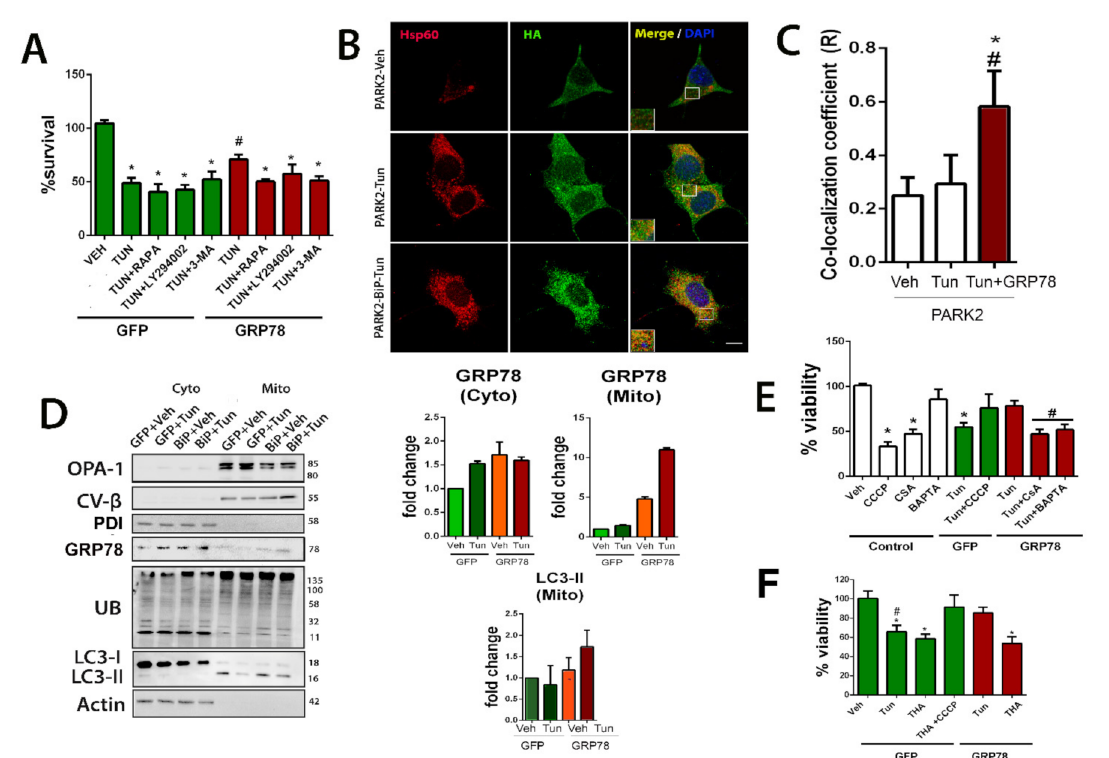
Figure 4. Mitochondria tagging for mitophagy is privileged by GRP78 overexpression. ( A ) Bar graph of the percentage of viable NSC34 cells (mean ± SEM) nucleofected with either GFP or GRP78 plasmids and treated with Tun or combination of Tun with autophagy modulators: rapamycin (RAPA), 3MA, or LY-902, with respect to control vehicle (Veh), determined by MTT assay 24 h after treatment (GFP-Veh is the control group) ( n = 4–8, * p < 0.05 vs. Veh-GFP; # p < 0.05 vs. Tun-GFP). ( B ) Representative confocal images of cells nucleofected with PARK2-HA plasmid alone (top, middle panels, control) or with GRP78 plasmid (bottom panels) treated with either vehicle (Veh) or Tun (5 h) and immunostained for HA (green) and HSP60 (red); scale bar = 10 µ m. ( C ) Average ± SEM of Pearson’s correlation coefficient of Parkin and Hsp60 co-localization from Veh, Tun and Tun+GRP78 groups ( n = 4; * p < 0.05 vs. Parkin-Veh, # p < 0.05 vs. Parkin-Tun, one-way ANOVA). ( D ) Left , Western blots for indicated proteins in the mitochondrial (mito) and cytosolic (cyto) pooled fractions from GFP- or GRP78-overexpressing cells treated with vehicle or Tun for 5 h. The proteins analyzed are: OPA-1, CV- β , PDI, GRP78, Ubiquinated residues, LC3 and actin. Right , bar graphs of the average fold change of GRP78 in both pooled fractions and LC3-II in the mitochondrial fraction relative to actin (cytosol) or the beta subunit of the complex V(CV-B) (mitochondria) in the GFP group. ( E ) Bar graph of the percentage of viable cells (means ± SEM) overexpressing GFP or GRP78 proteins and treated with Tun alone or in combination with CCCP, CSA, or BAPTA-AM, determined by MTT assay 24 h after treatment with respect to control vehicle-treated cells. ( F ) Similar bar graph of cell viability for cells treated with thapsigargin (THA) with or without CCCP (GFP-Veh is the control group) ( n = 4–8, in 3 different experiments, * p < 0.05 vs. control-Veh; # p < 0.05 vs.